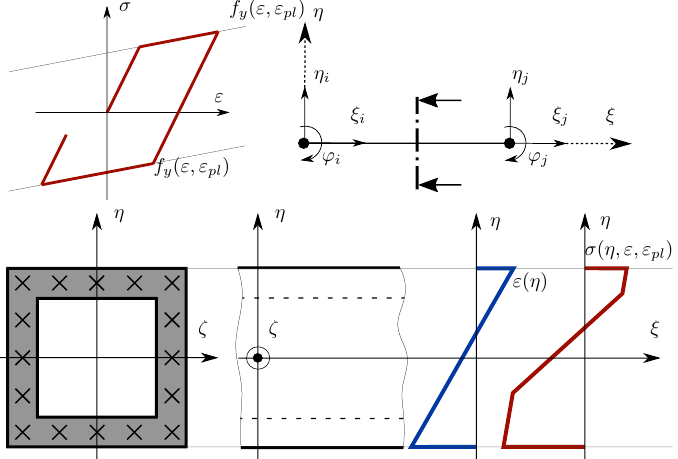
Figure 10. Beam elements with a hollow cross section and elastoplastic material behavior with kinematic hardening.